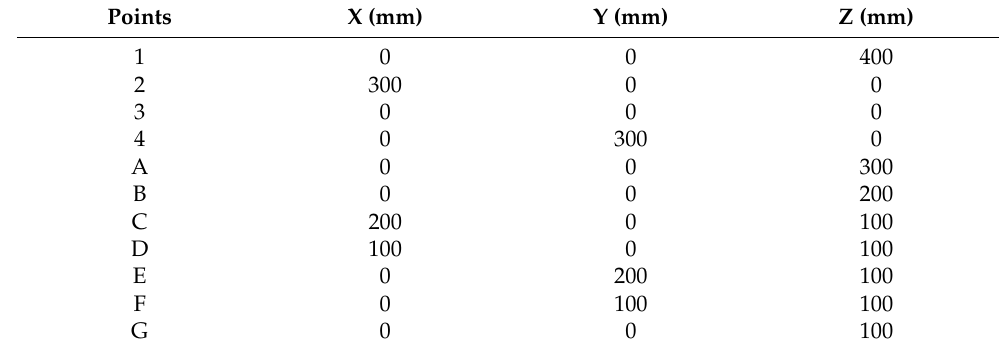
Table 2. The object space coordinates.